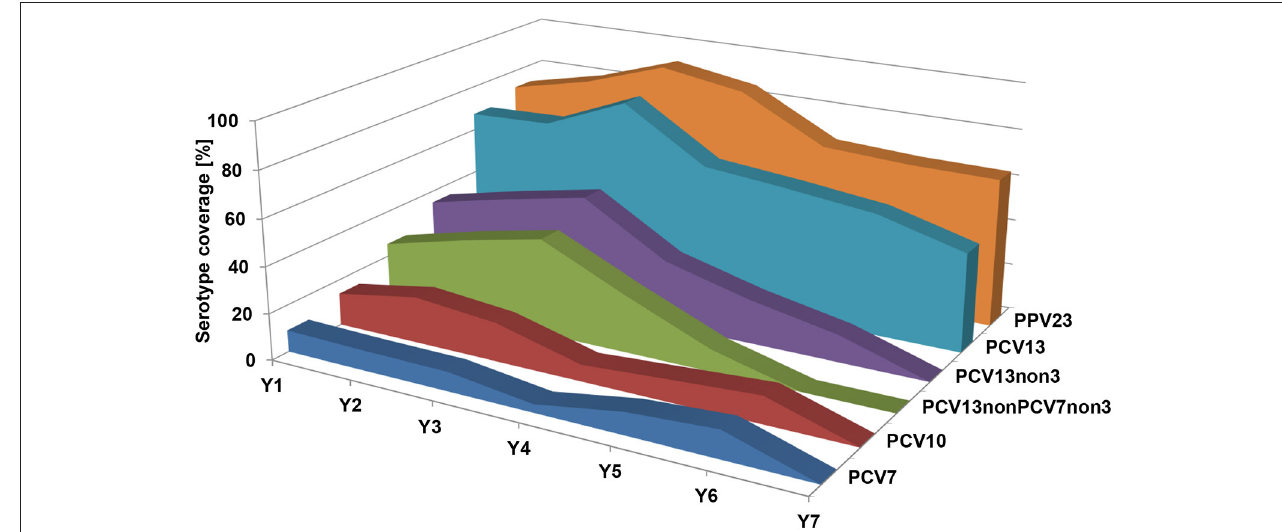
FIGURE 4 | Prevalence of S. pneumoniae serotypes among MEF isolates over the seven study years, grouped by different vaccine formulations. PCV7, serotypes included in PCV7; PCV10, serotypes included in PCV10; PCV13, serotypes included in PCV13; PCV13-non-PCV7-non-3, PCV13 serotypes, excluding PCV7 serotypes and serotype 3; PCV13-non-3, PCV13 serotypes excluding serotype 3; PPV23, serotypes included in